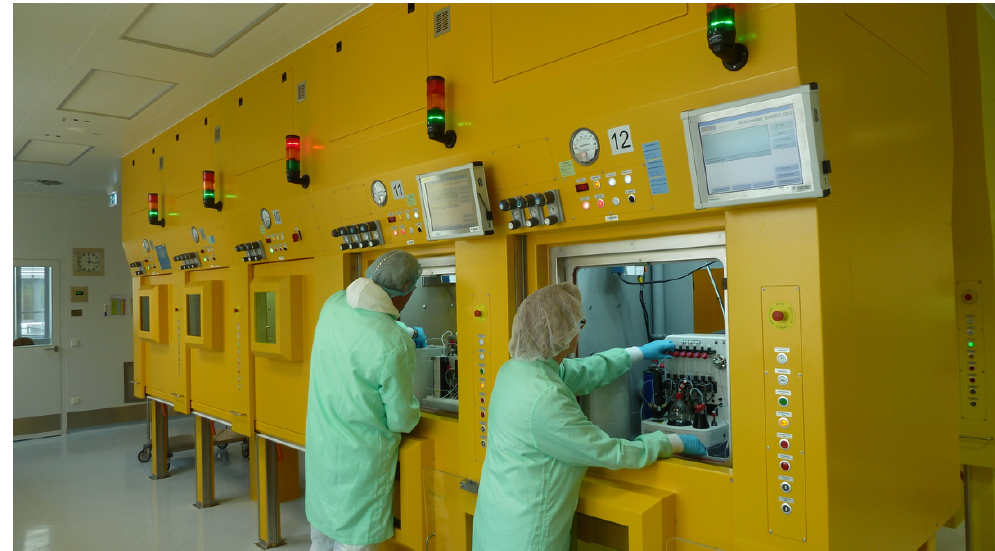
Figure 2. GMP area including the hot cells for the radiopharmaceutical production.